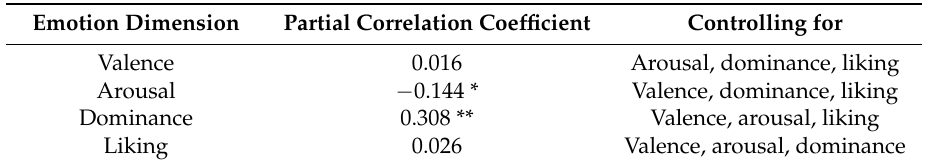
Table 2. Partial correlation coefficients ( N = 189) between participants’ wine–music matching scores and emotion similarity ratings. * indicates significance at the 0.05 level, ** indicates significance at the 0.01